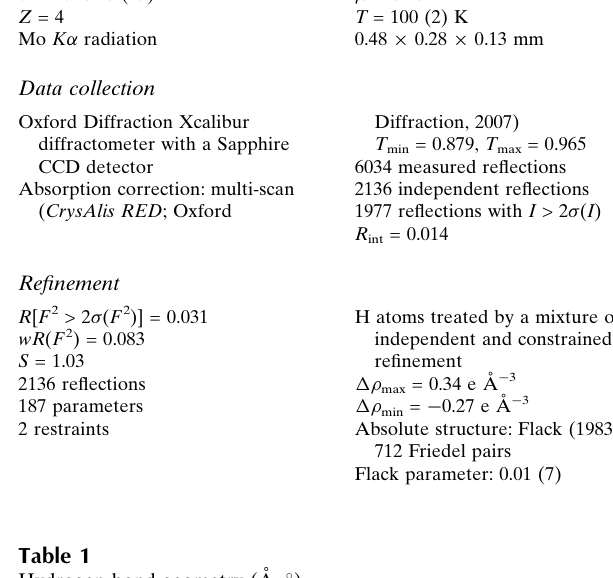
Hydrogen-bond geometry (A˚ , (cid:1)